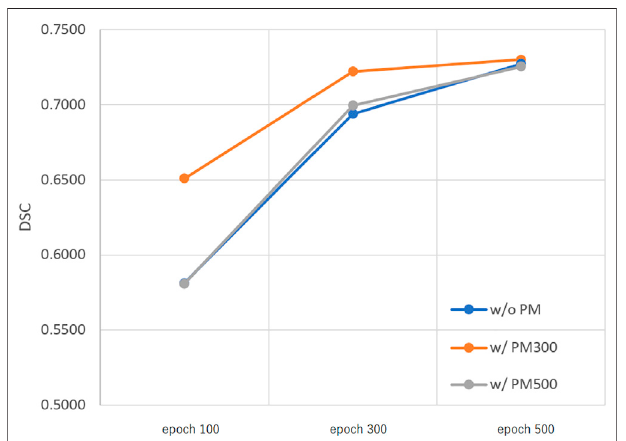
FIGURE 3 | Mean DSC of the test set when using Decathlon full . Abbreviation: PM, pretrained model; PM 300 , pretrained model obtained from 300epochsoftraining;PM 500 ,pretrainedmodelobtainedfrom500epochsof training.